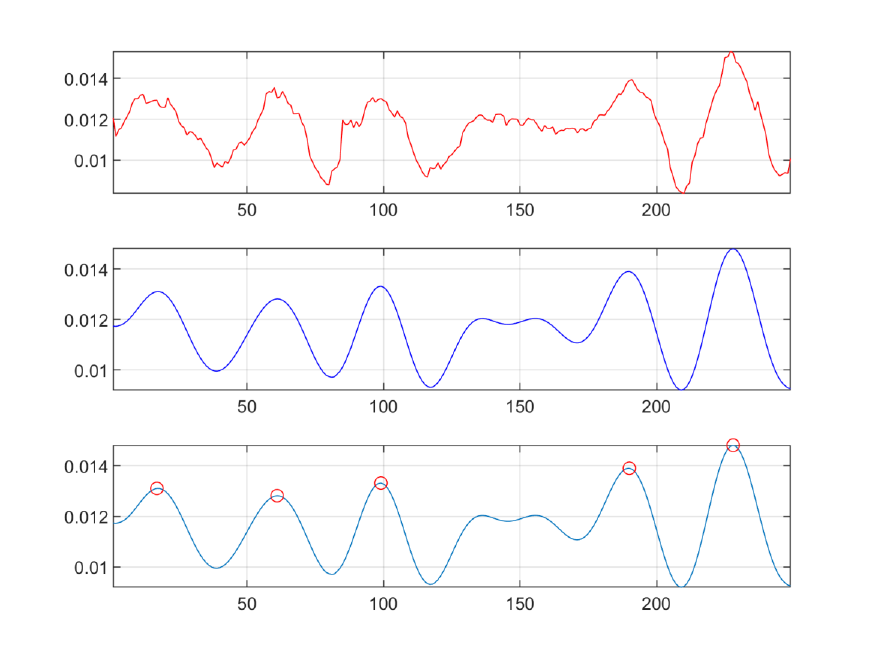
Figure 5. The extracted signal from the video A1. It corresponds to the tile shown in Figure 4. The first signal is the temporal intensity changes in the difference image sequence. The band-passed and smoothed signal is shown in the middle and the detected peaks are marked on the third signal. x and y axes represent the number of frames and the intensity difference